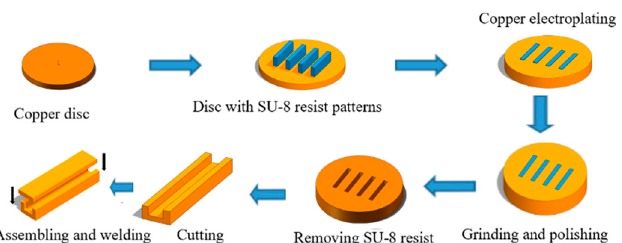
Figure 2. UV-LIGA process for creating the complete electromagnetic transmission channel of the WR2.8 waveguide: (1) preparing oxygen-free copper discs with 8 mm thickness and 3-inch diameter; (2) forming a SU-8 pattern using the lithography process; (4) electroforming copper between the cross-linked SU-8 patterns; (5) grinding and polishing the electroformed copper wafer to 355 µ m; (6) removing SU-8 photoresist; (7) cutting the sample; (8) bonding the channel block and the copper plate cover via diffusion welding.